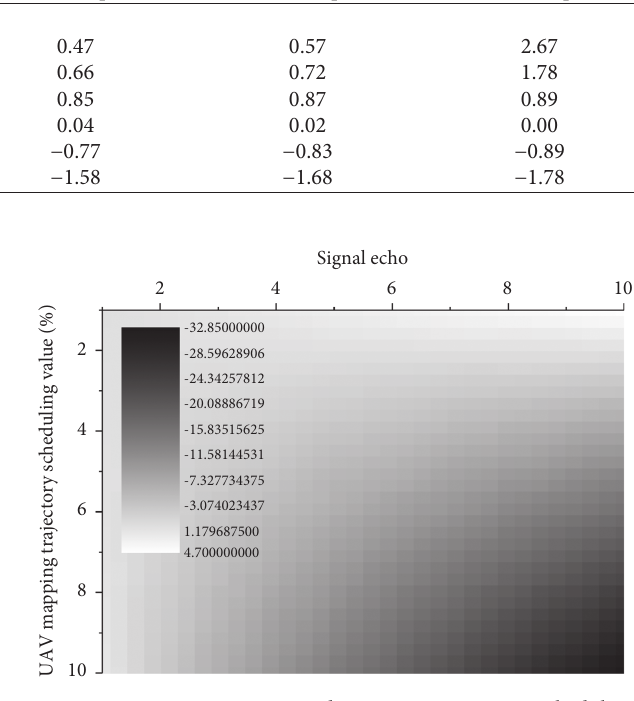
Figure 2: UAV surveying and mapping trajectory scheduling